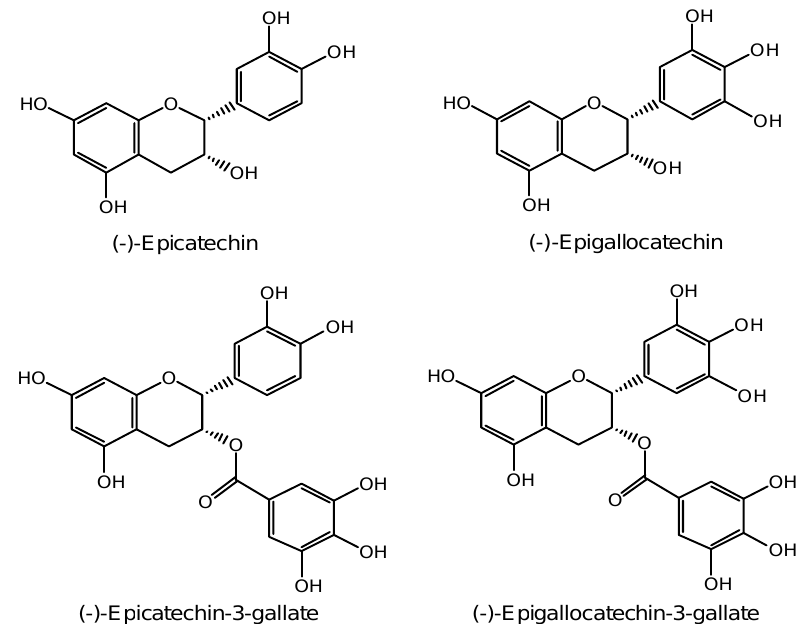
Figure 1. Main catechin components of green tea